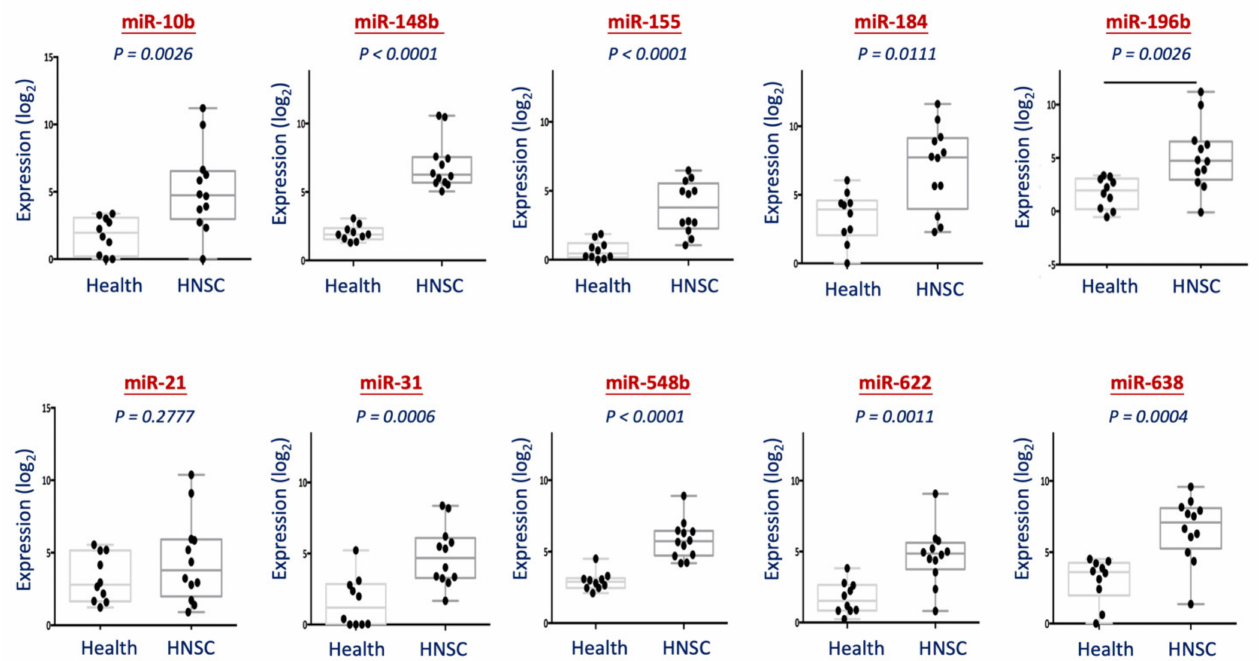
Figure 2. Analysis of the 10 miRNAs from saliva specimen between healthy individuals and HNSC patients. For each sample, the salivary miRNA was extracted and analyzed using a PCR-based method. The differential levels of the 10 miRNAs (miR-10b, miR-148b, miR-155, miR-184, miR-196b, miR-21, miR-31, miR-548b, miR-622, and miR-638) from healthy individuals and patients with HNSC were shown. The dot at the center of the box plot represents the mean expression for each